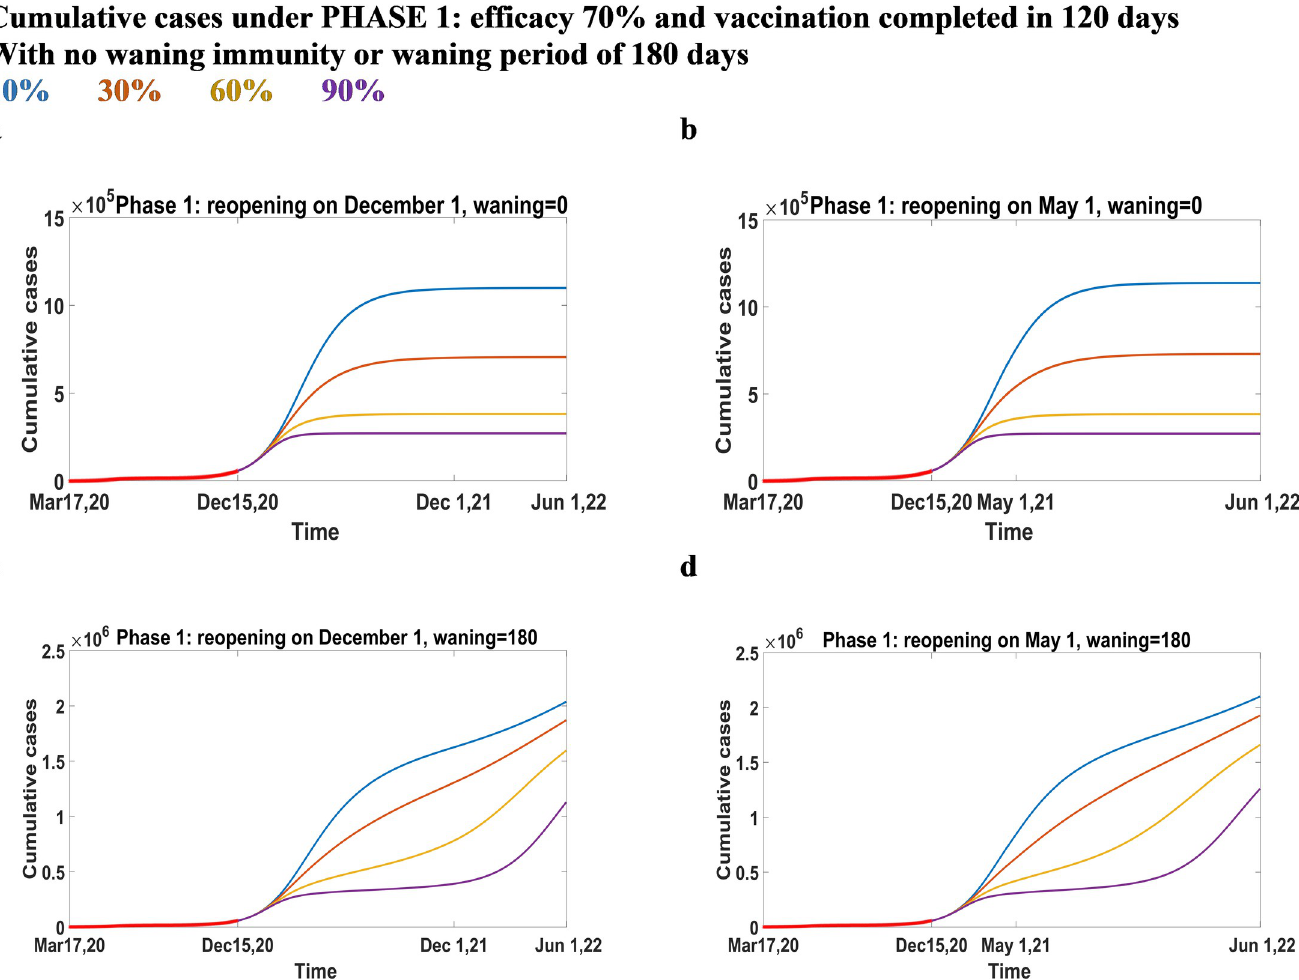
Fig 5. Cumulative cases under Phase 1: Efficacy 70% and vaccination completed in 120 days. Cumulative cases when the vaccine efficacy is 70%, vaccination is completed in 120 days under Phase 1 conditions, reopening in December 2021 (a-c) or May 2021 (b-d) and immunity does not wane (a-b) or wanes over 180 days (c-